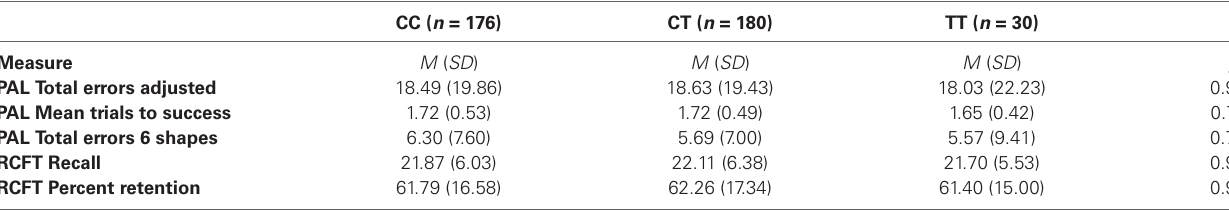
Table 3 | Visual episodic memory performance across KIBRA